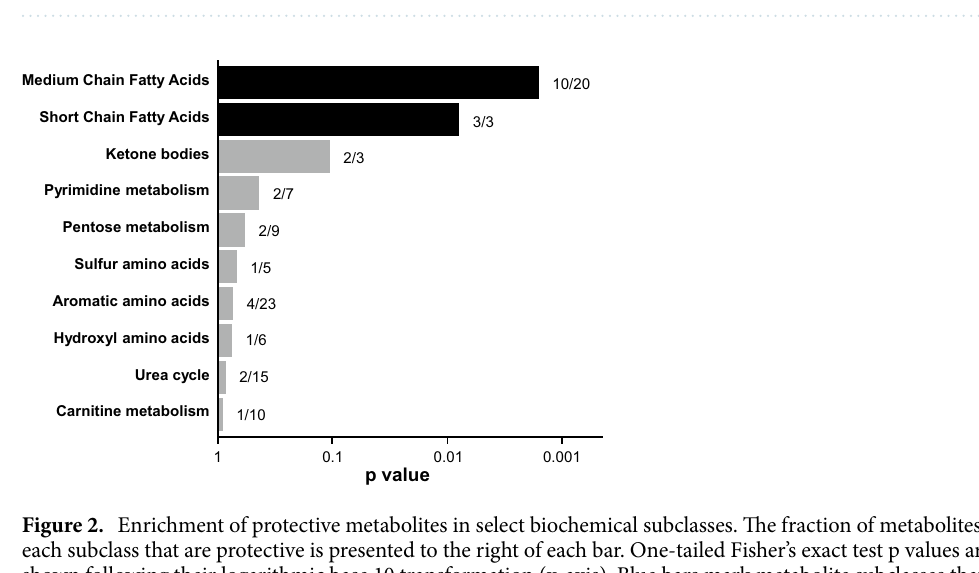
Figure 1. Global analysis of metabolite associations with recent, persistent normoalbuminuria in subjects with long duration of T1D and normal renal function. The analysis is adjusted for clinical covariates. Well-detectable metabolites are shown. The magnitude of the effect is shown as fold change (x-axis) cross-referenced against the strength of the associations represented as significance from the logistic regression model adjusted for clinical covariates (y-axis). The grey line marks the threshold of significance at Bonferroni corrected α = 0.000028. Each point represents an individual metabolite. Dark blue triangles mark significant Medium Chain Fatty Acids. Light blue diamonds mark other significant protective metabolites. Orange squares mark significant risk metabolites. MCFA Medium Chain Fatty Acid.